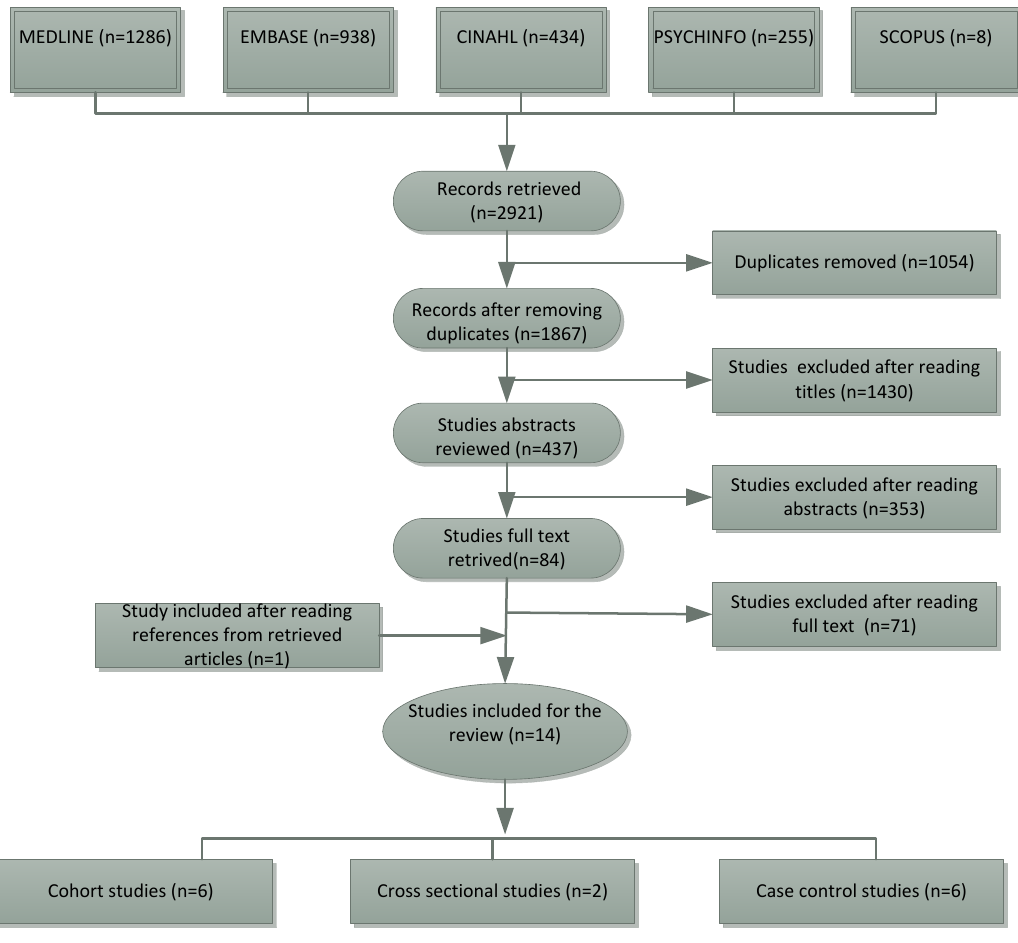
Figure 1. The flow chart for study selection based on PRISMA 2015 guidelines.